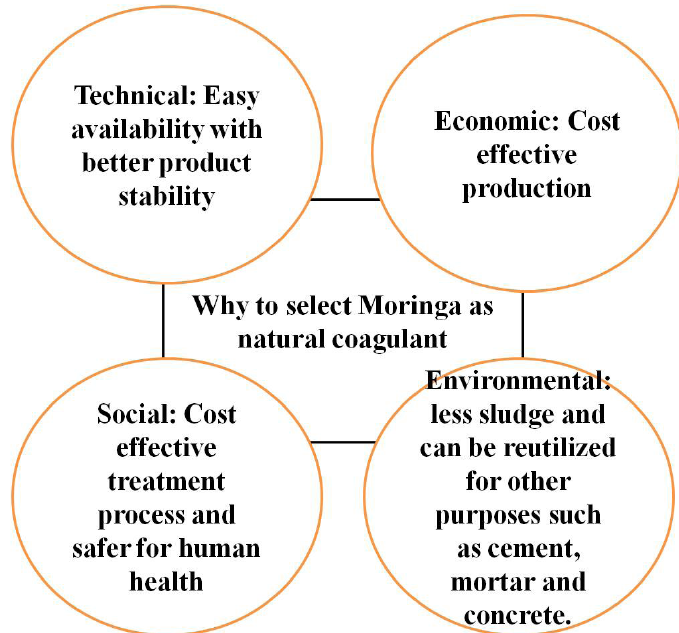
FIGURE 2 - Moringa versus chemical/synthetic coagulants. Braz. J. Pharm. Sci. 202 2 ;58 :